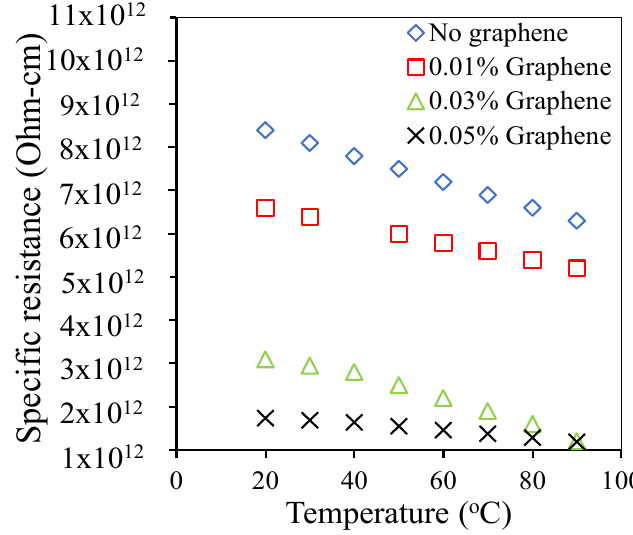
Figure 6. Variation of specific resistivity of graphene–transformer oil nanofluid with temperature.